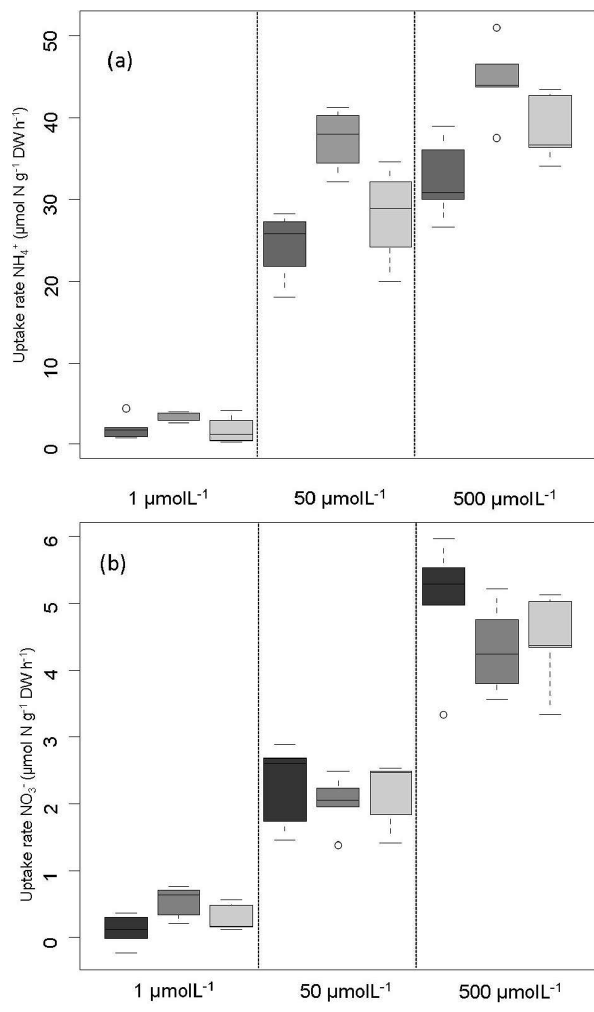
Figure 5. Differences between average uptake rates ( m mol N gDW 2 1 h 2 1 ) after 0.5 hours in different fractions of Sphagnum magellanicum from the pristine site. We analysed capitula and stems separately, while whole plant values represent the DW weighted mean of both fractions.